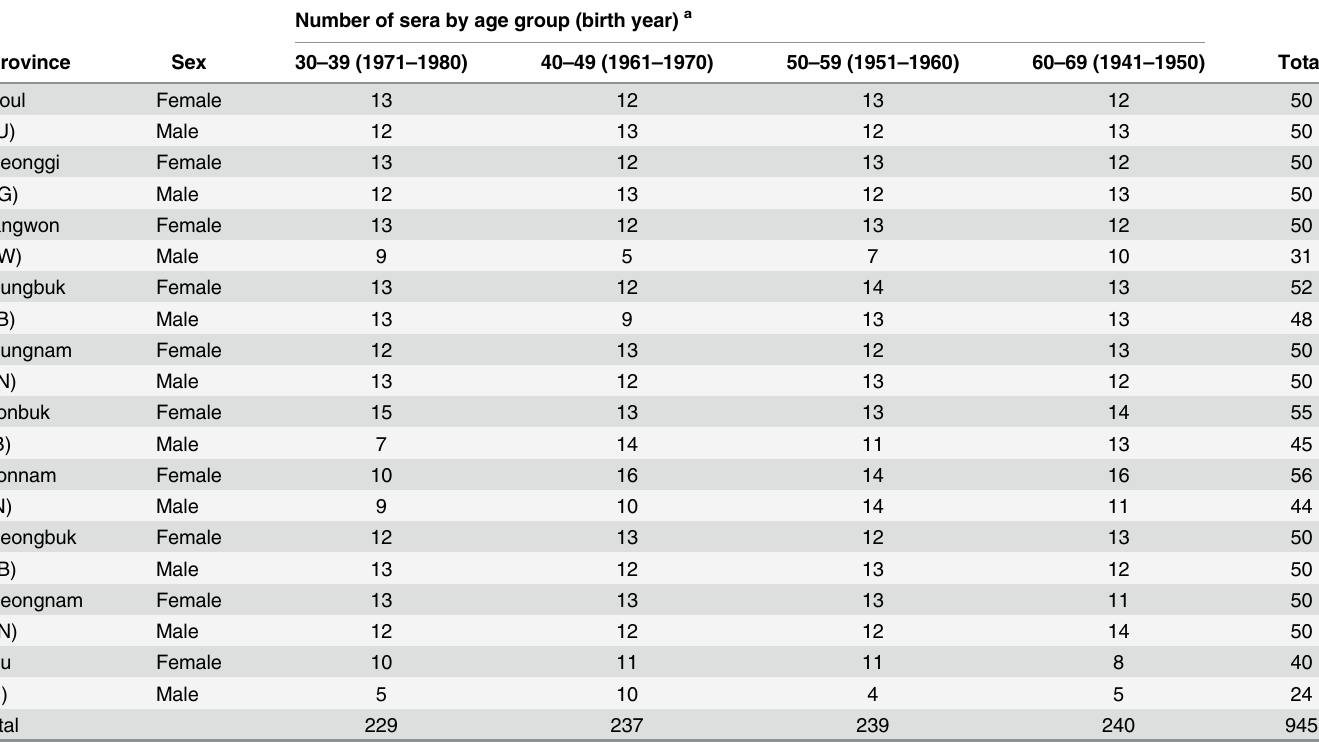
Table 2. Distribution of the subjects enrolled in this study. Number of sera by age group (birth year)